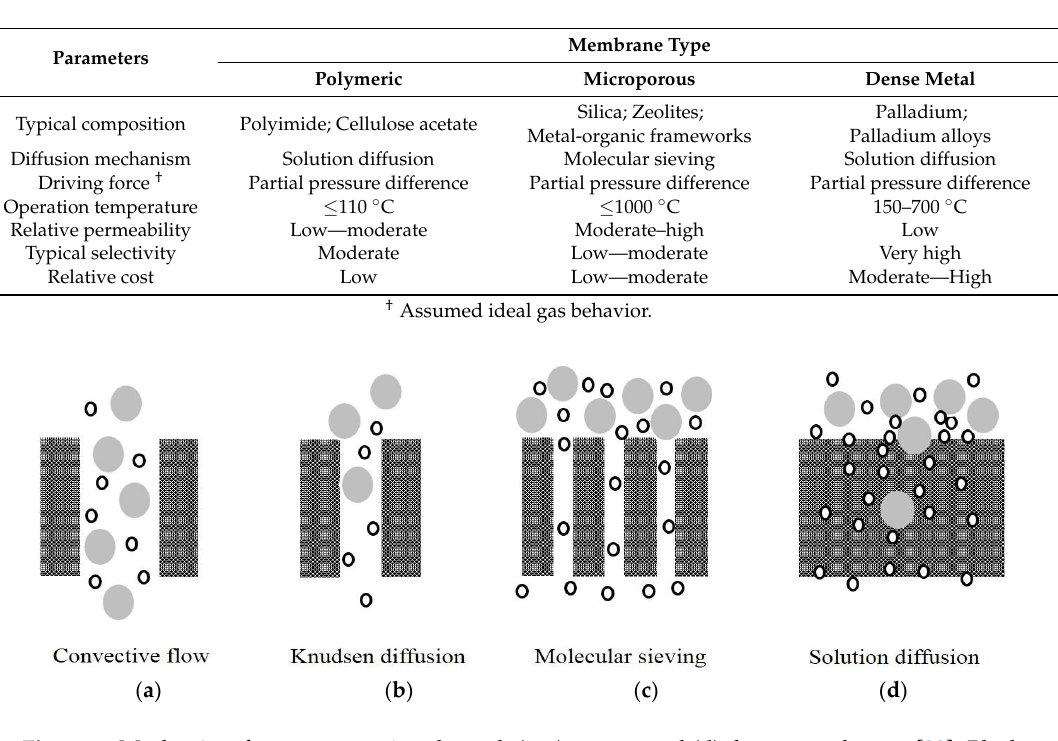
Table 1. Types of hydrogen separation membrane. Table adapted with permission of the authors of [29].